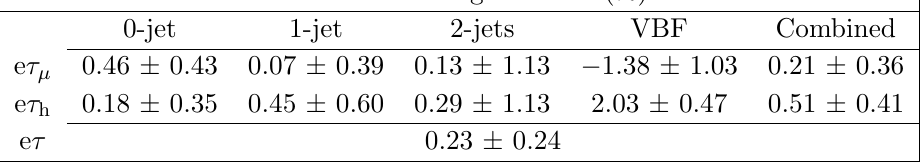
Table 7 . Expected and observed upper limits at 95% CL and best (cid:12)t branching fractions in percent for each individual jet category, and combined, in the H ! e (cid:28) process obtained with the M col (cid:12)t